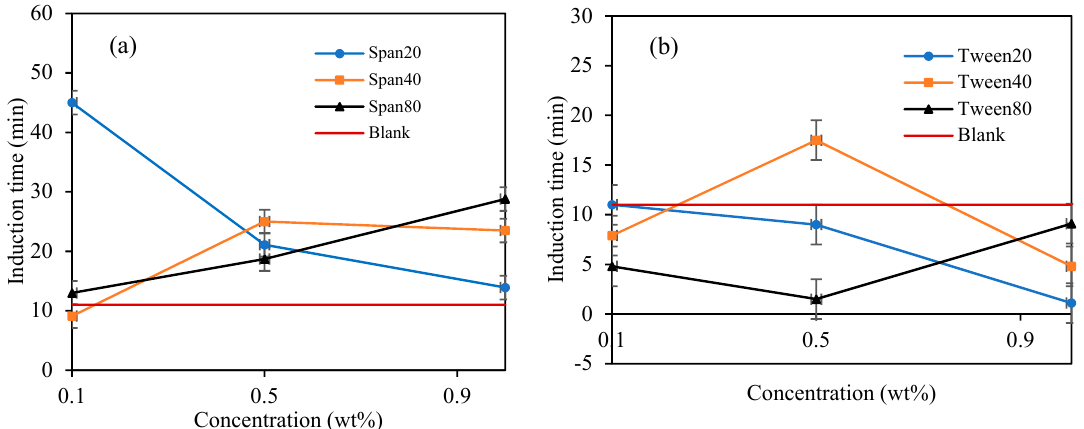
Figure 8. The e ff ect of Span and Tween concentrations (% v / v ) on CP–hydrate formation induction time. Figure 8. The effect of Span and Tween concentrations (% v/v ) on CP–hydrate formation induction (CP / H2O: 50 / 50; aging temperature 2.0 deg C); ( a ) Span surfactants, ( b ) Tween time. (CP/H2O: 50/50; aging temperature 2.0 deg C); ( a ) Span surfactants, ( b ) Tween surfactants.